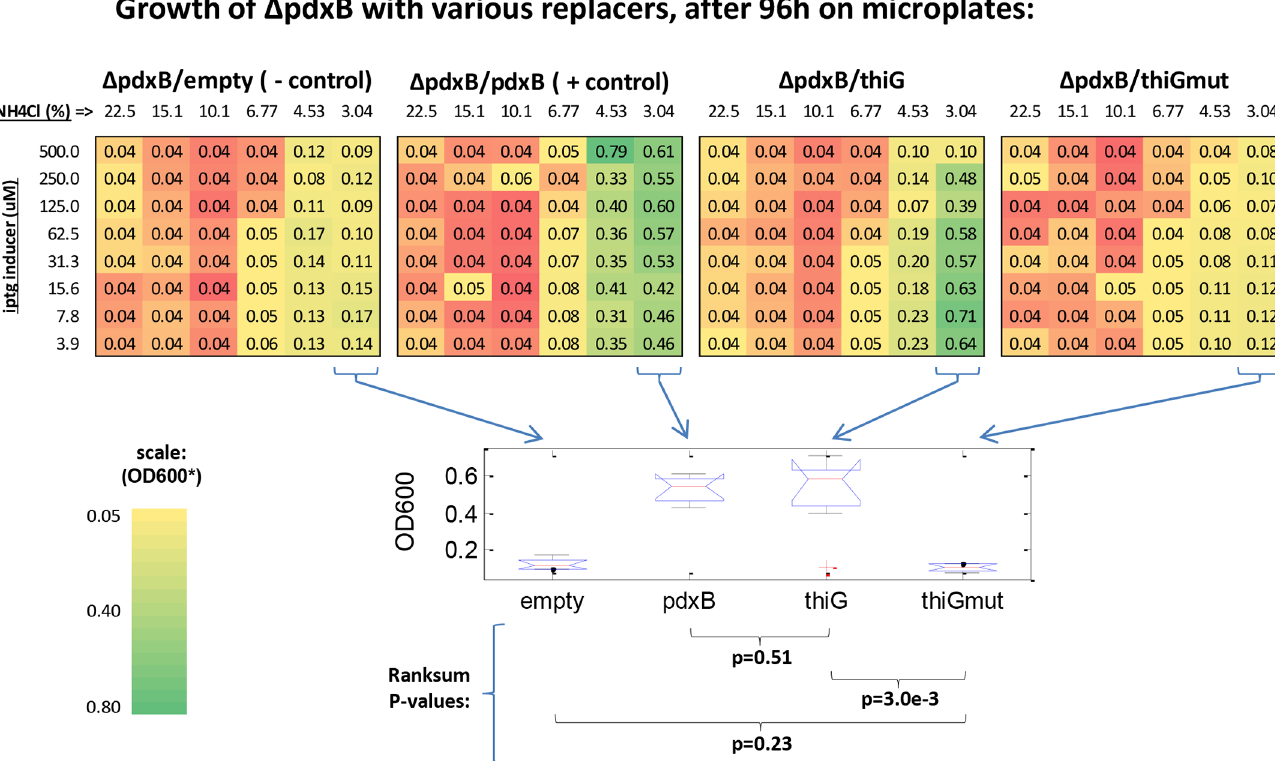
Fig 3. Inactivating the thiG proposed secondary active site removes its ability to replace pdxB . Four strains ( Δ pdxB/empty [- control], Δ pdxB/pdxB [+ control], Δ pdxB/thiG , Δ pdxB/thiGmut ) were grown for 96 hours in deep-well microplates, in which a checkerboard matrix of varied IPTG (inducer) and NH 4 Cl (nitrogen source) concentration in M9 glucose were assessed. Values shown are representative OD 600 readings at 96 hours post-inoculation. Additional OD 600 data are provided in S5 Table. Box plots of OD 600 values at ~3% NH 4 Cl (across IPTG concentrations) are shown in lower panel, along with the results of Ranksum tests of OD 600 values between relevant strain pairs.